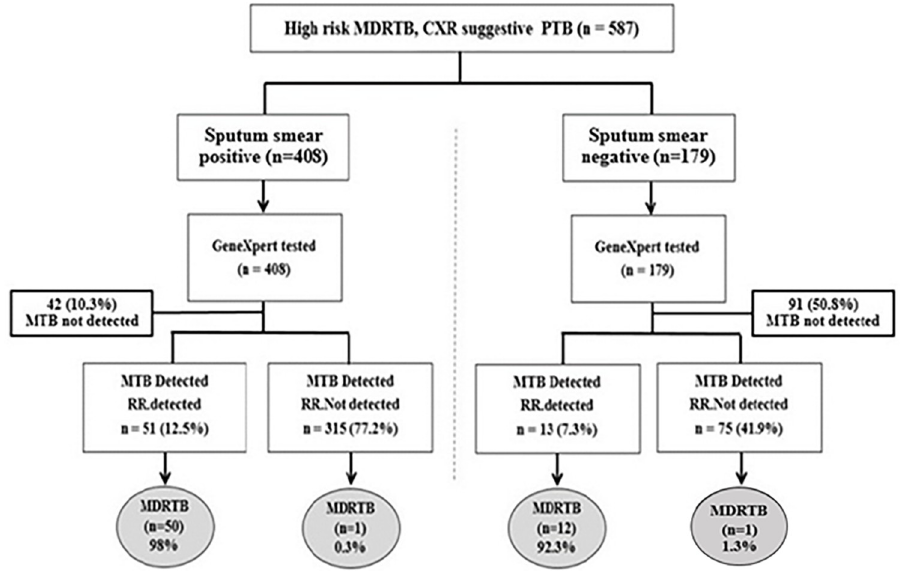
Fig 2. Decisions in TB diagnosis among high-risk MDR-TB